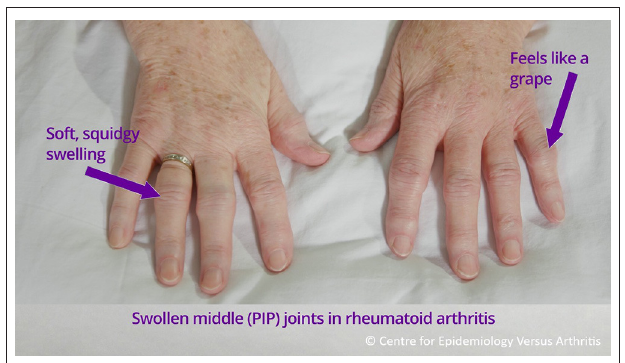
FIGURE 2 | Instructions for self-examination of proximal interphalangeal joints (PIP), extracted from self-examination video.